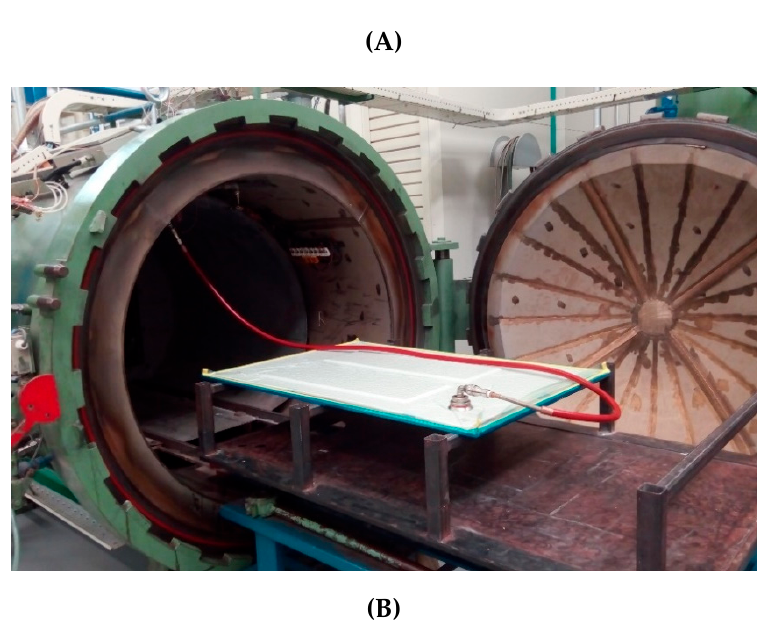
Figure 1. ( A ) The laminating process and ( B ) the curing process in the autoclave.